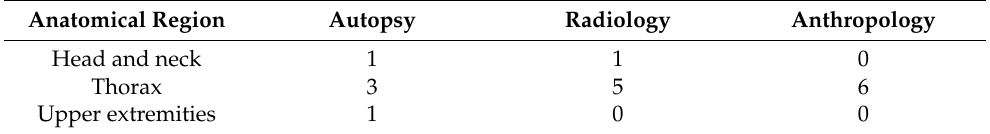
Table 5. Number of undetected bone lesions (BL) in the three different investigations from twelve cases. Anatomical